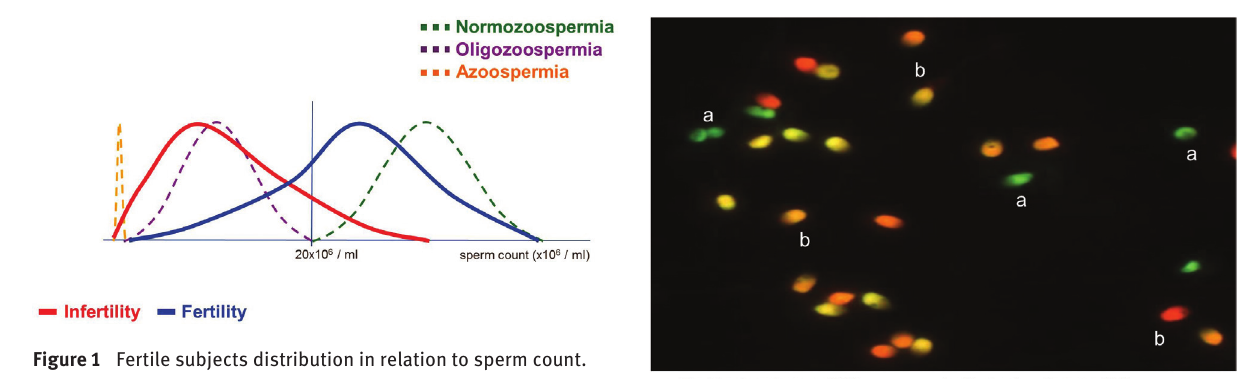
Figure 1 Fertile subjects distribution in relation to sperm count.